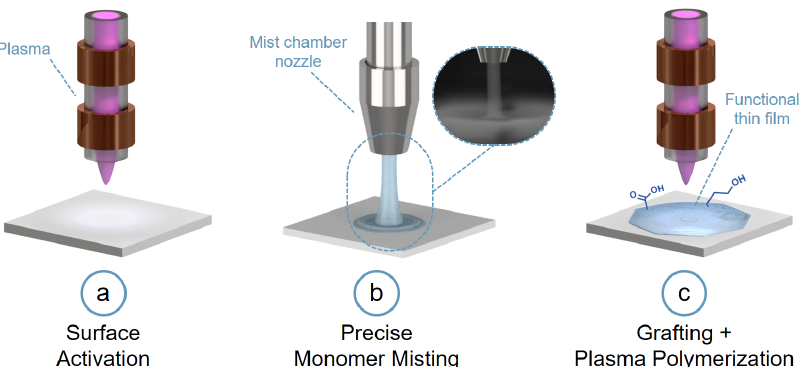
Figure 1. Process steps for the plasma-based synthesis of pp films obtained from liquid monomers. ( a ) plasma activation of the substrate’s surface; ( b ) deposition of the misted monomer onto the substrate to form a thin liquid layer (mist chamber outlet with focusing nozzle, orifice of Ø = 2 mm, distance to substrate 2 mm); and ( c ) polymerization of the deposited liquid monomer film via plasma